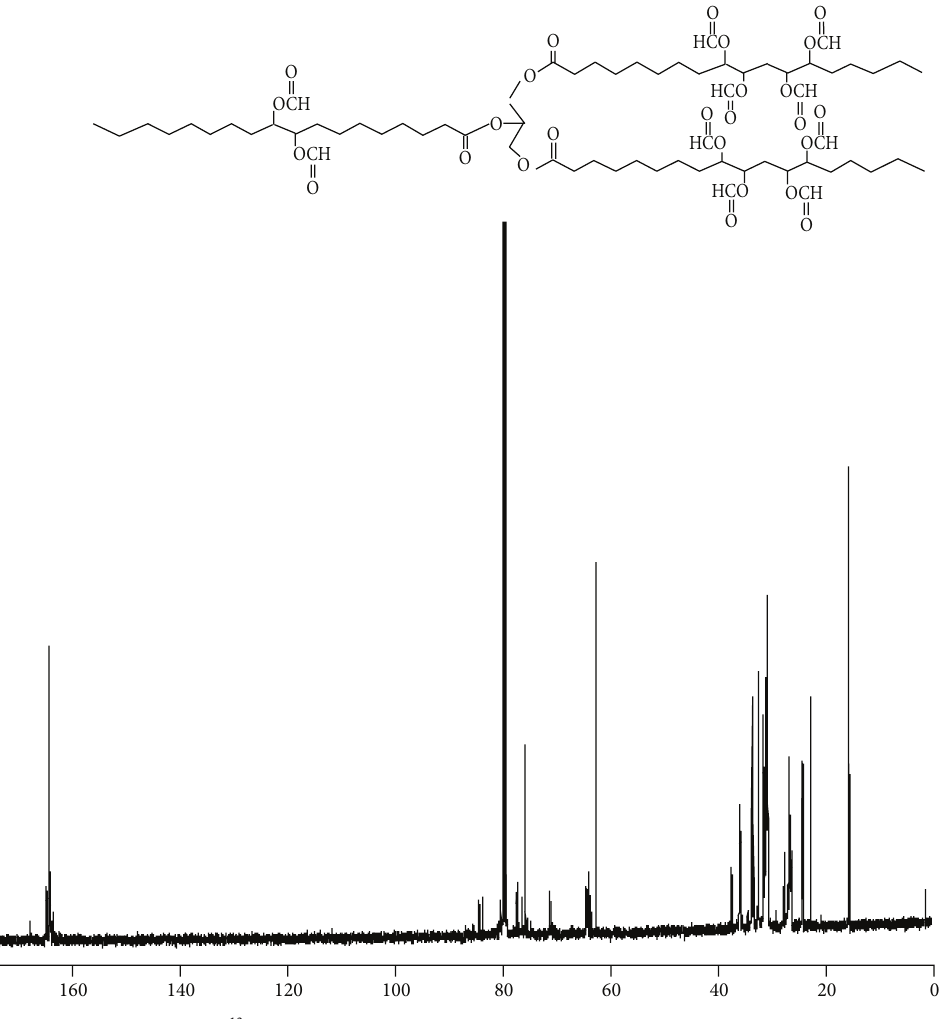
Figure 5: 13 CNMR spectrum of the polyformyl ester of milkweed